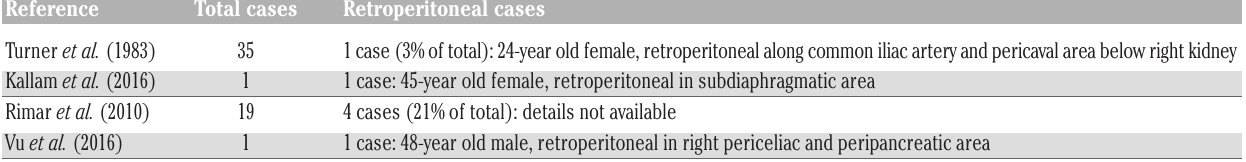
Table 1. Description of cases with retroperitoneal lymph node involvement. Reference Total